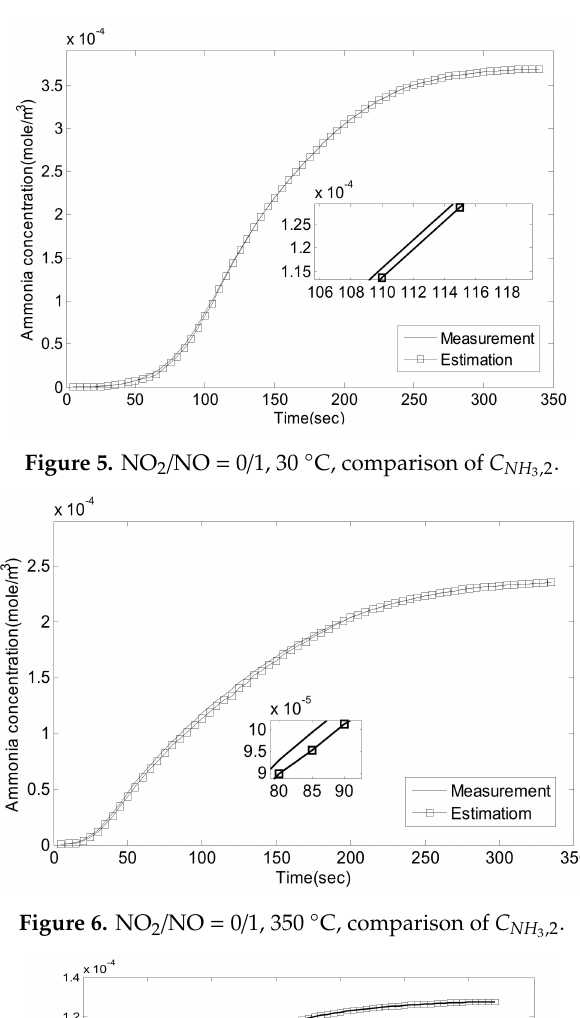
Figure 6. NO 2 / NO = 0 / 1, 350 ◦ C, comparison of C NH